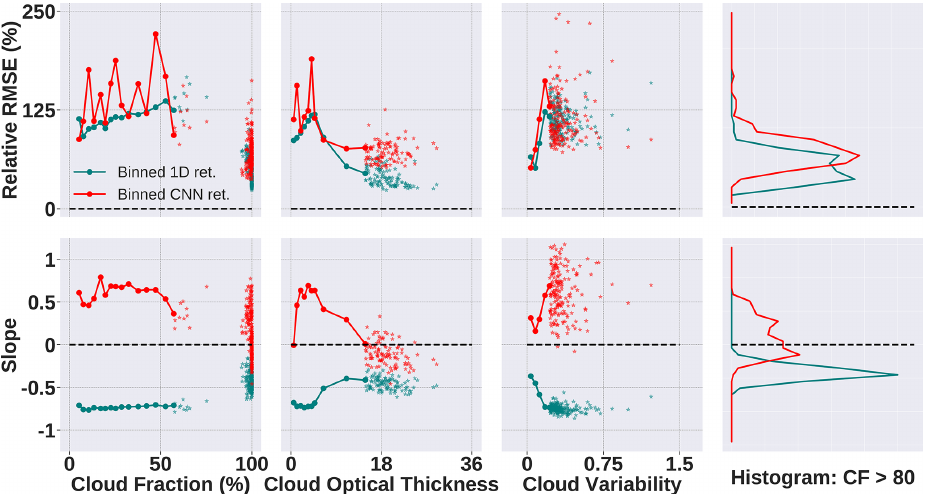
Figure 13. Comparison of CNN (shown in red) and IPA or 1D retrieval (shown in teal) when being evaluated on a new geographic region (Atlantic, Sect. 2.1.2). The CNN is trained on the gridded and/or sampled data set consisting of images from 1 × 1, 2 × 2, and 4 × 4 coarsening factor domains. The dashed black line depicts the ideal